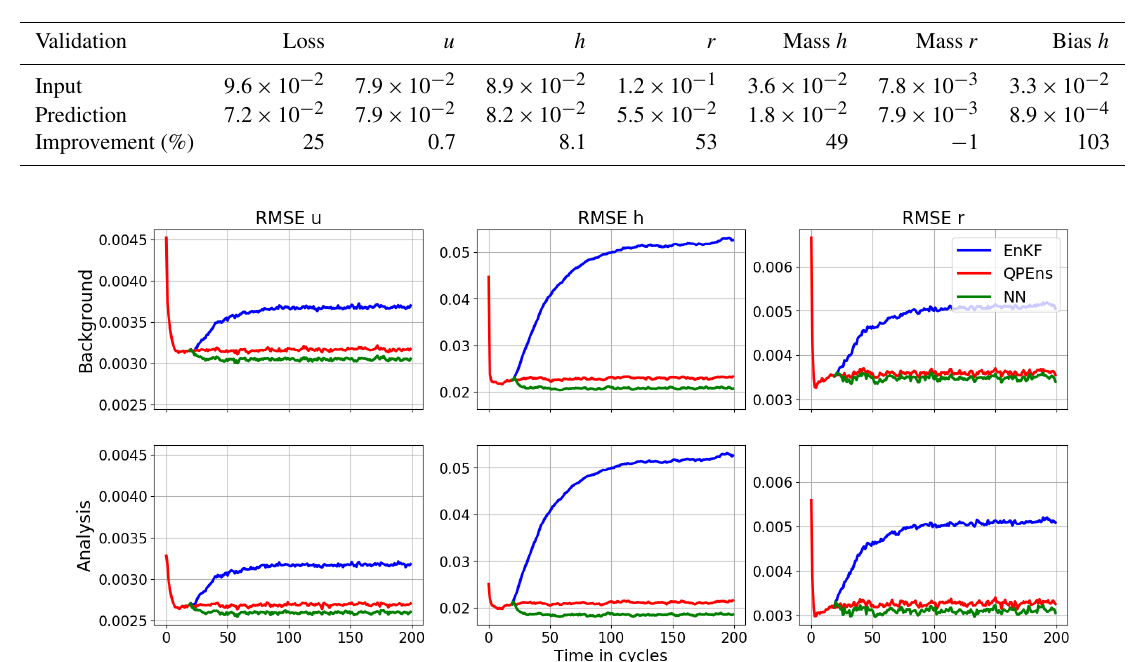
Figure 6. The same as Fig. 3 but for dT10 η = 2 .